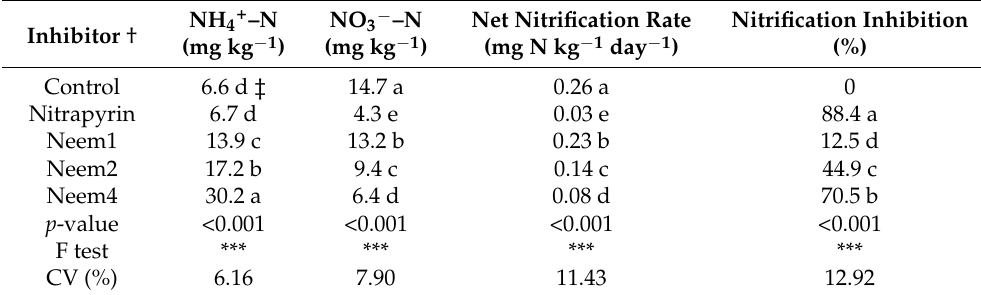
Table 6. Soil ammonium and nitrate nitrogen concentrations at the lettuce harvest as affected by different nitrification inhibitors.